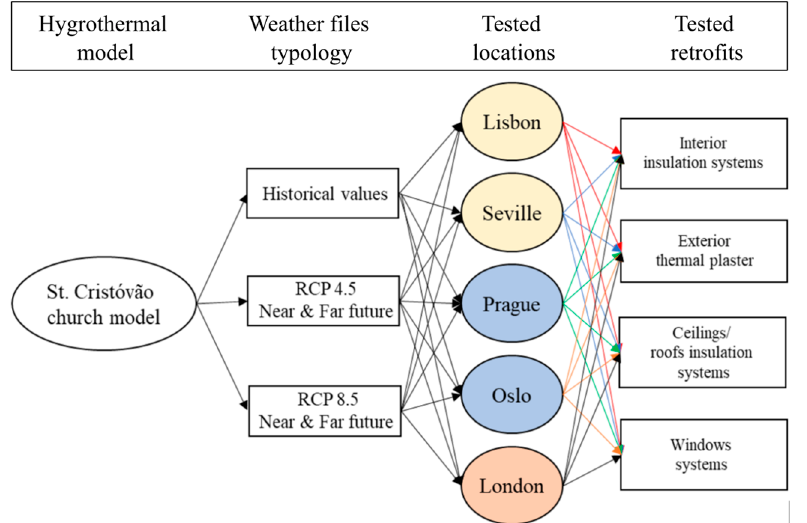
Figure 8. Scheme of the developed simulations in Ref. [34] to assess the performance of four types of retrofit measures in historic buildings that house artifacts for five climates and two IPCC scenarios in the near future and far future in terms of artifacts conservation metrics.